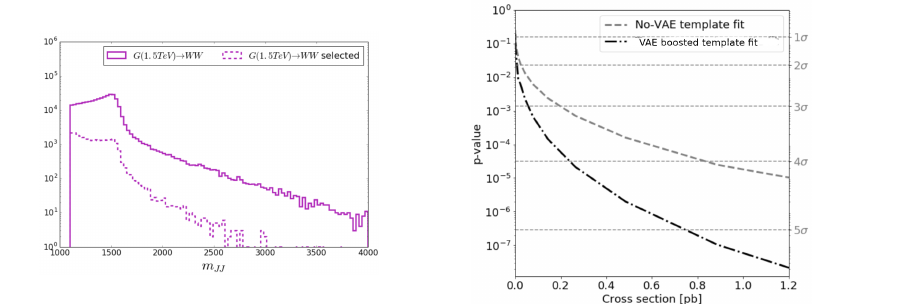
Figure 10. G RS → WW benchmark. Left plot: Dijet mass spectrum of total (solid line) vs selected (dashed line) events after loss cut. Right plot: Cross section and p-value significance for analysis on original dataset (grey line) and VAE loss cut filtered dataset (black